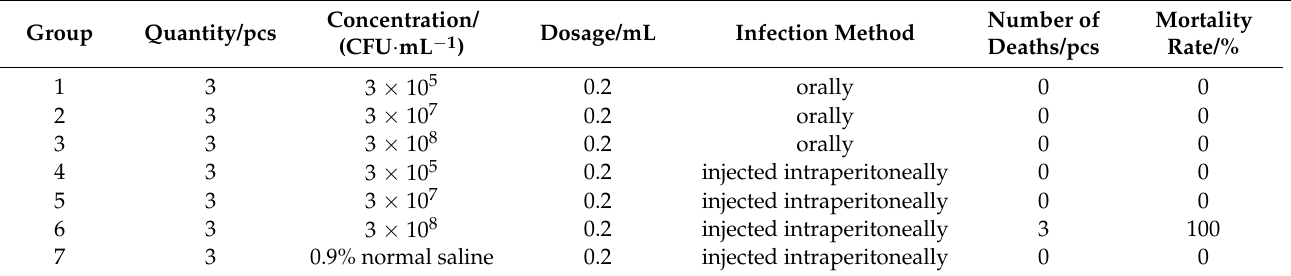
Table 2. Results of the animal pathogenicity experiment.